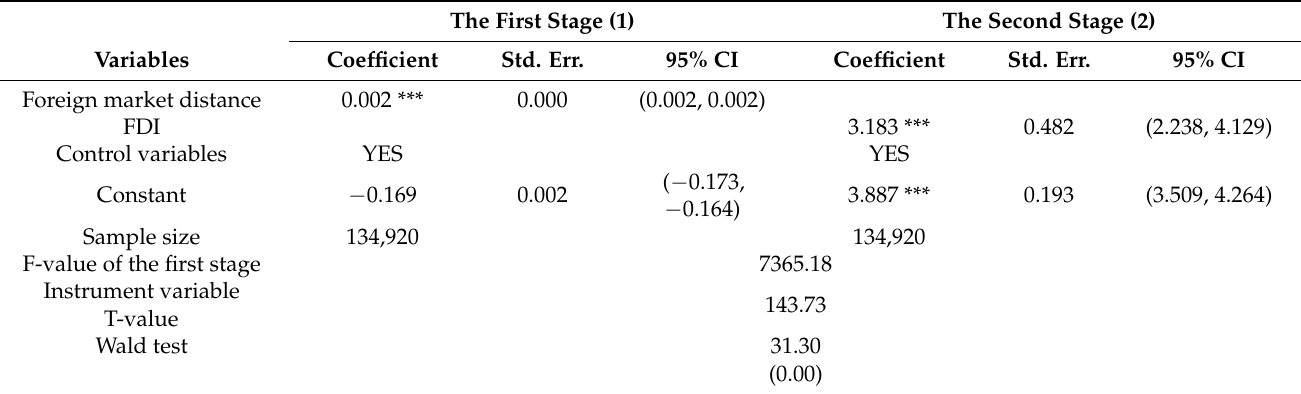
Table 3. Endogeneity test of the influence of FDI on rural-urban migrants’ physical health.